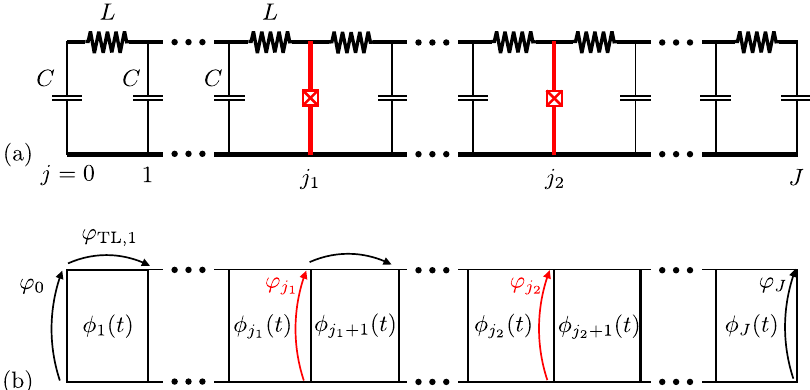
Fig. 5 Finite element approach. a Finite element model to describe the SQUID geometry in Fig. 4(a). The upper arm of the SQUID is described through a transmission line, whereas the lower arm is simply a ground. The Josephson junctions (red) are at positions j = j 1 and j = j 2 . b The same fi nite element model, now showing the temporally and spatially varying fl ux ϕ j t ð Þ , as well as the branch phase variables for the transmission line, φ TL, j , and the ones describing the capacitive and Josephson coupling between ground and transmission line, φ j